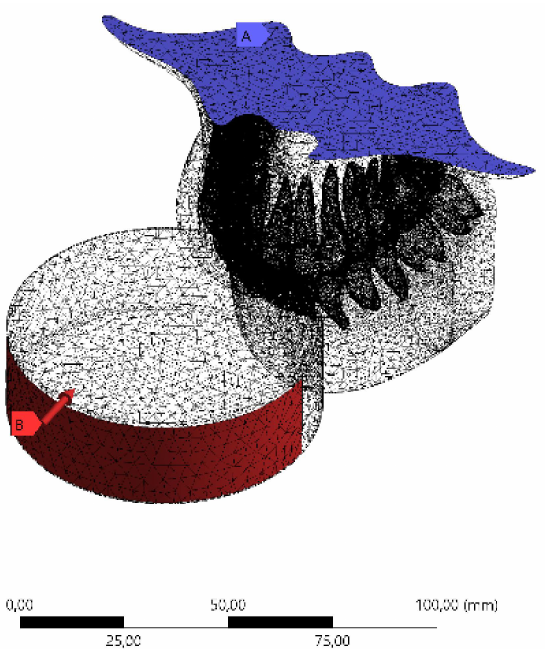
Figure 3. Boundary conditions in the 3D finite element model: Meshing subdivision and fixed support with impact path restricted to the y -axis.